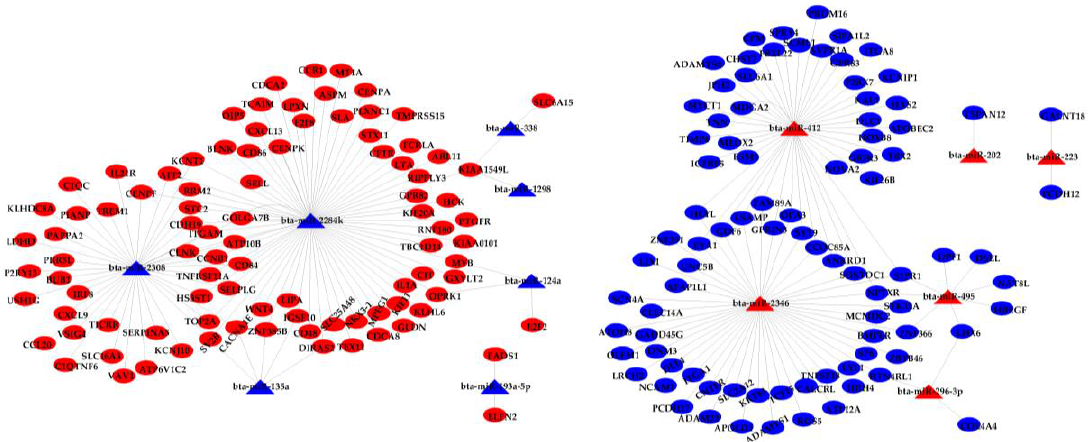
Figure 4. A network map of the pairs of DE miRNAs and DE mRNAs. The blue triangles represent the downregulated miRNAs, and the red triangles represent the upregulated miRNAs. The blue ellipses represent the downregulated mRNAs, and the red ellipses represent the upregulated mRNAs.